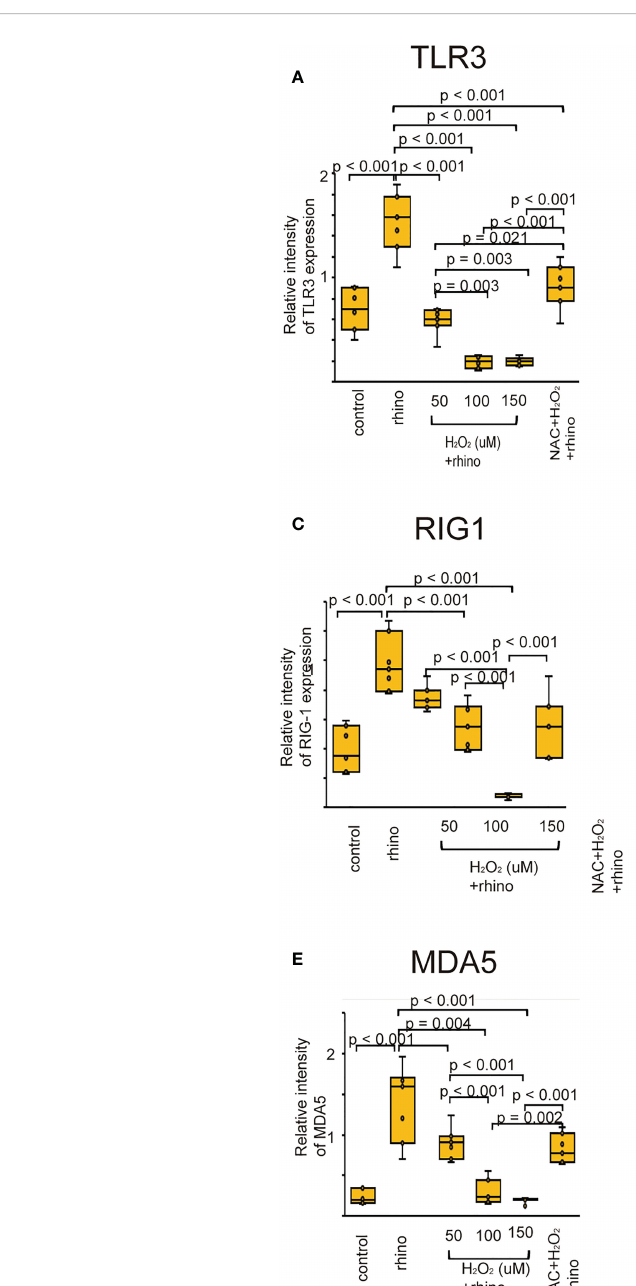
FIGURE 5 The expression level of TLR3 (A, B) , RIG-I (C, D) , and MDA5 proteins (E, F) in sinonasal epithelial cells pretreated with H 2 O 2 at 50, 100, and 150 uM and then, followed by RV 16 infection (A, C, E) or poly (I: C) treatment (B, D, F) which were evaluated with western blot. Data are mean ± SEM from 7 different epithelial donors. Control indicates non-treated normal epithelial cells. Rhino indicates epithelial cells infected with RV 16. H 2 O 2 + rhino indicates the epithelial cells pretreated with H 2 O 2 at 50, 100, and 150 uM followed by RV 16 infection. NAC+ H 2 O 2 +rhino indicates the cells which were pretreated with NAC at 5 mM for 1 h and then followed by H 2 O 2 treatment at 100 uM and subsequently infected with RV 16. Poly (I: C) indicates epithelial cells treated with poly (I: C). H 2 O 2 + poly (I: C) indicates the epithelial cells pretreated with H 2 O 2 at 50, 100, and 150 uM followed by poly (I: C) treatment. NAC+ H 2 O 2 + poly (I: C) indicates the cells which was pretreated with NAC at 5 mM for 1 h and then followed by H 2 O 2 treatment at 100 uM and subsequently treated with poly (I: